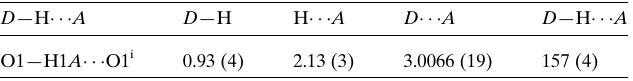
Table 2 Hydrogen-bond geometry (A˚ , (cid:3) ).